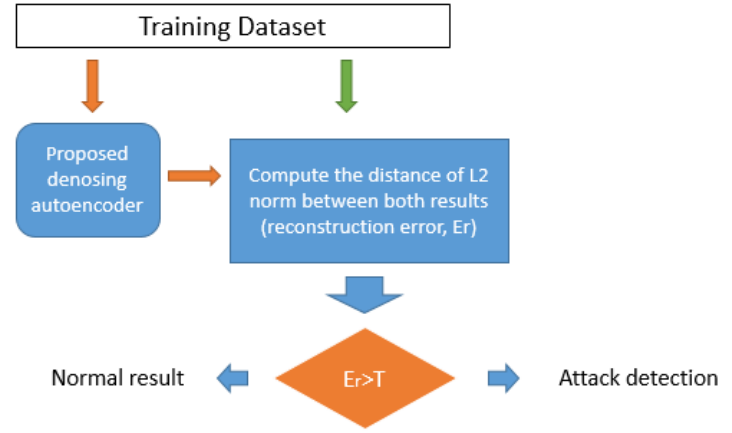
Figure 4. Flowchart showing detection of other attacks in IDA algorithm.